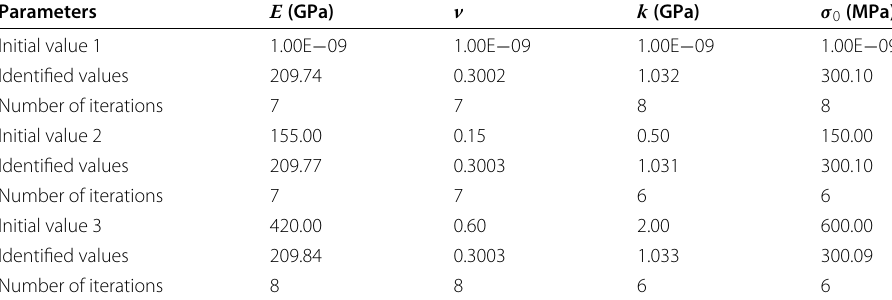
Table2 Sensitivity to initial set of parameters: specimen 2 Parameters